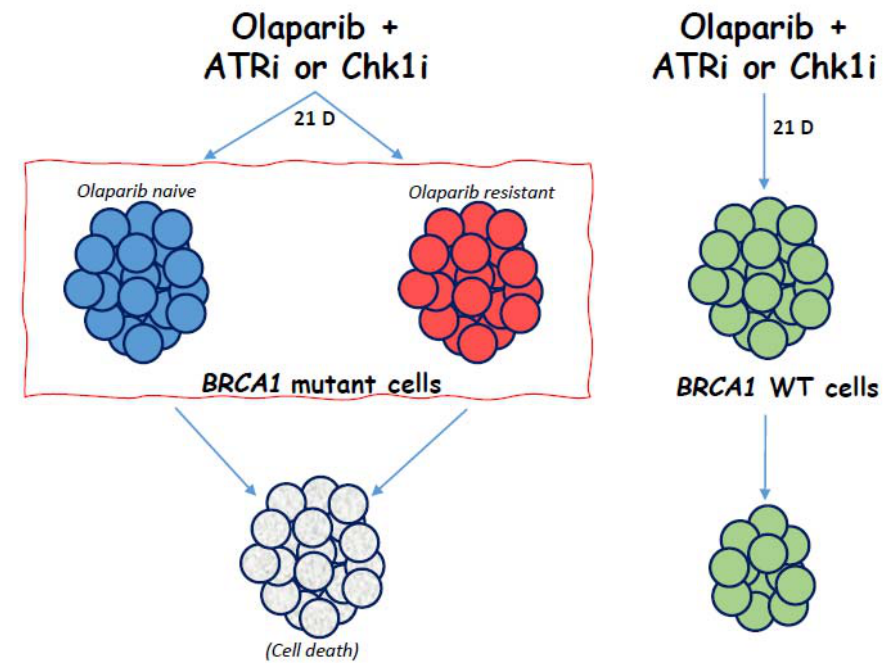
Figure 5. Treatment of BRCA1 mutant cells, regardless of olaparib-resistant status, results in cell population death with Olaparib + ATRi or Olaparib + Chk1i. BRCA1 wild-type cell population is decreased only slightly with the same treatment.